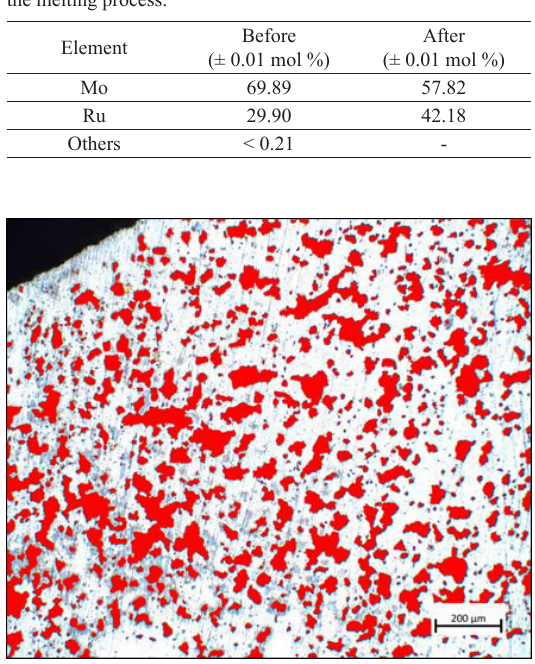
Figure 9. Optical micrograph of a decoppered sample taken with the microscope porosity analysis